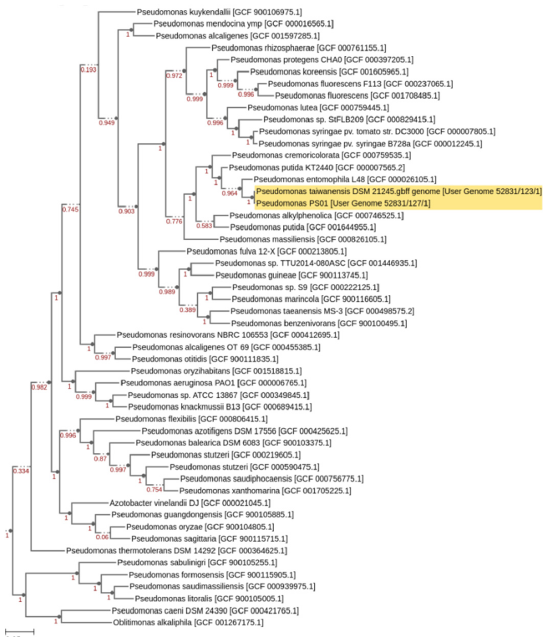
Figure 3. Taxonomic assignment of strain PS01. Phylogenetic tree was constructed by combining the genome of PS01 and P. taiwanensis DSM 21245 with a set of closely related genomes selected from all public KBase genomes using Insert Genome Into Species Tree 2.1.10 tool (http://kbase.us). Relatedness is determined by alignment similarity to a select subset of Clusters of Orthologous Groups domains. Next, a phylogenetic tree is reconstructed using FastTree (Version